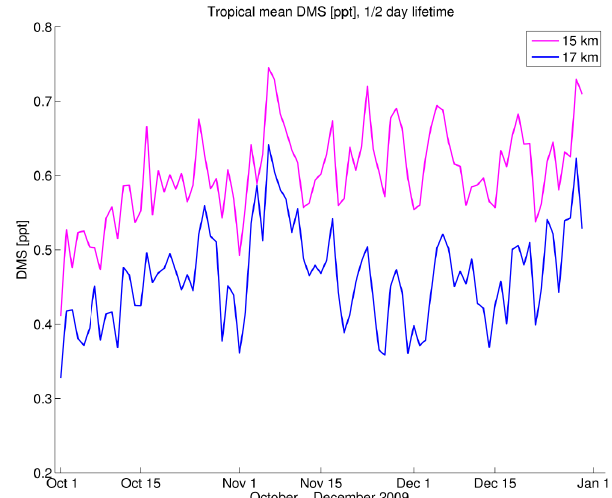
Fig. 6. Observed emissions of DMS at the ocean surface (black line), and total amount of DMS entrained above 17km based on FLEXPART simulations with 1-day (red line) and 1 / 2-day (green line) atmospheric lifetimes shown.